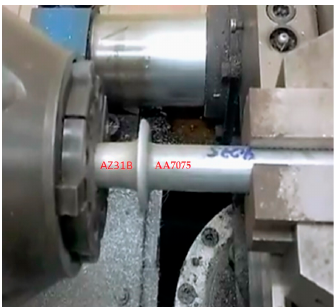
Figure 1. FRW of magnesium alloy to aluminum alloy.